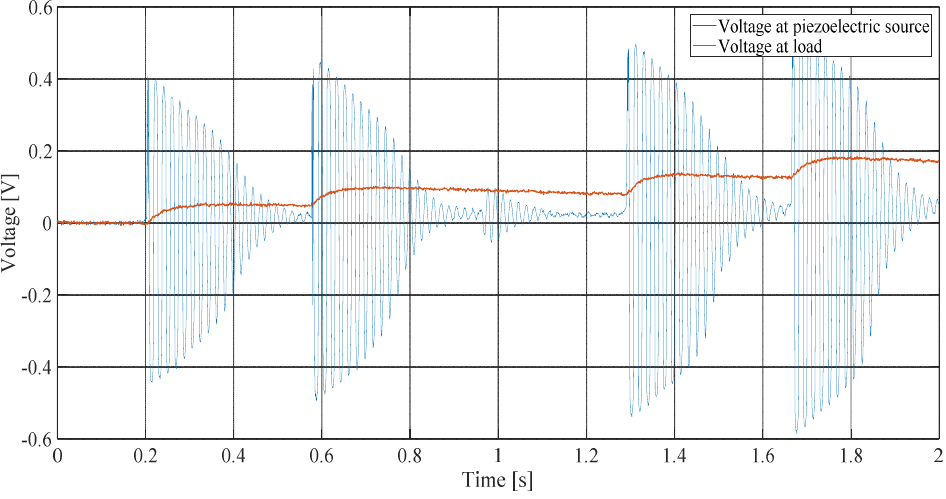
Figure 21. Transient voltage obtained for full bridge rectifying circuit.